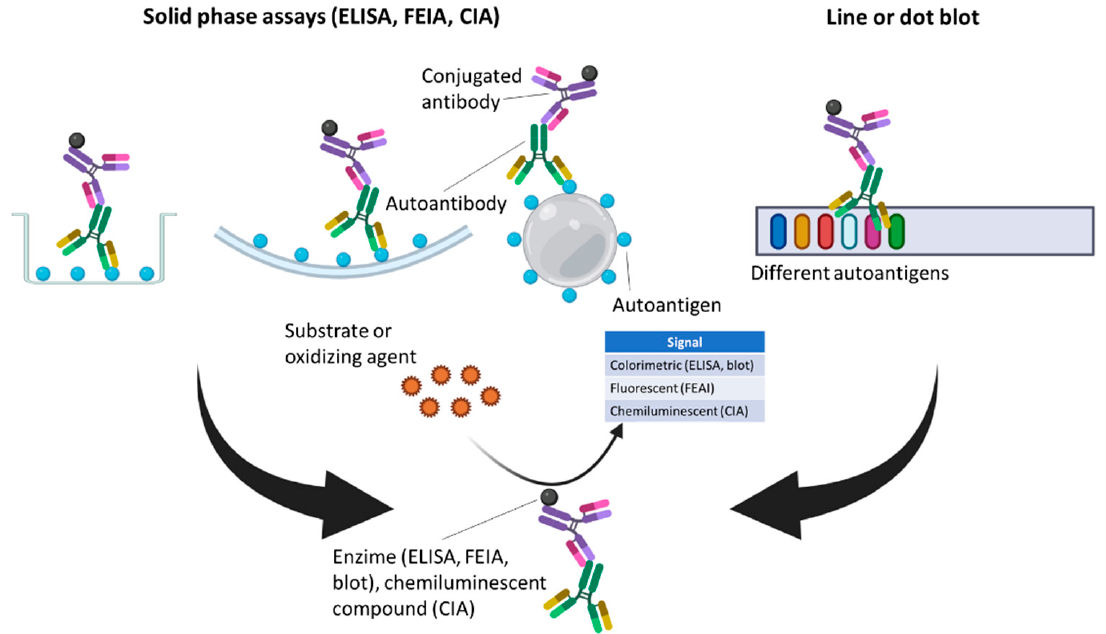
Figure 3. Solid-phase assays (ELISA, FEIA, and CIA) and line or dot blots as screening and confirma- tion methods for autoantibody detection.